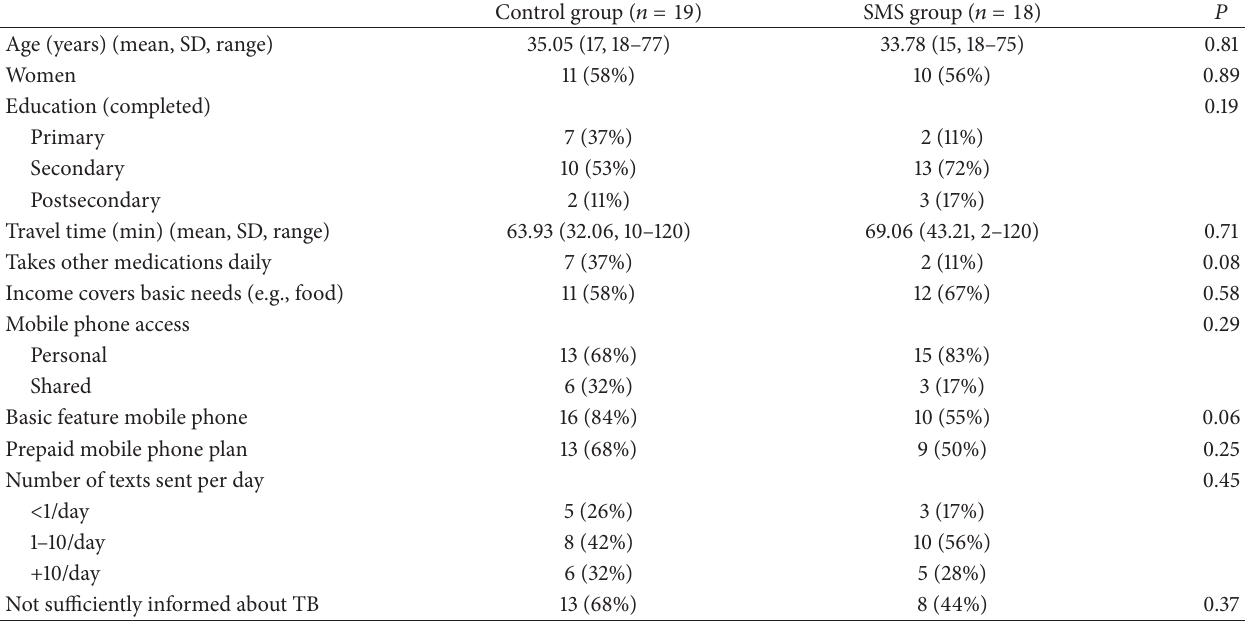
Table 1: Demographic and baseline